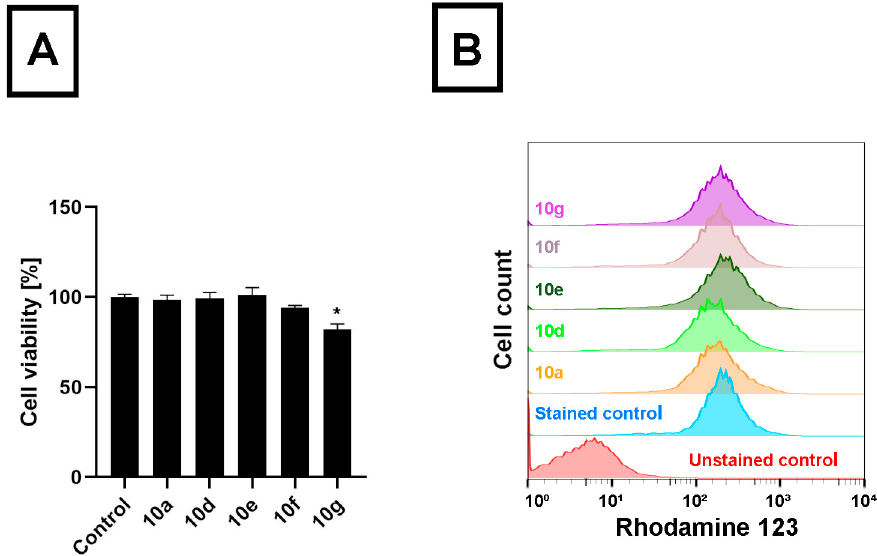
Figure 3. Androstano-arylpyrimidine 17-acetates do not cause Rhodamine 123 accumulation in Colo 205 cells. ( A ) Viability of Colo 205 drug-sensitive colon cancer cells following exposure to acetylated androstane compounds 10a, 10d, 10e, 10f, or 10g (20 µ M, 24 h treatment, 10 4 cells/well density) assessed by MTT cell viability assay. Bar graphs represent mean ± SD values. Fisher’s LSD test, *: p < 0.05. ( B ) Rhodamine 123 retentions of Colo 205 drug-sensitive colon cancer cells treated with acetylated androstane compounds 10a, 10d, 10e, 10f, or 10g (at 20 μ M concentration for 24 h). Rhodamine 123 fluorescence of at least 10,000 cells/sample was measured by flow cytometry.